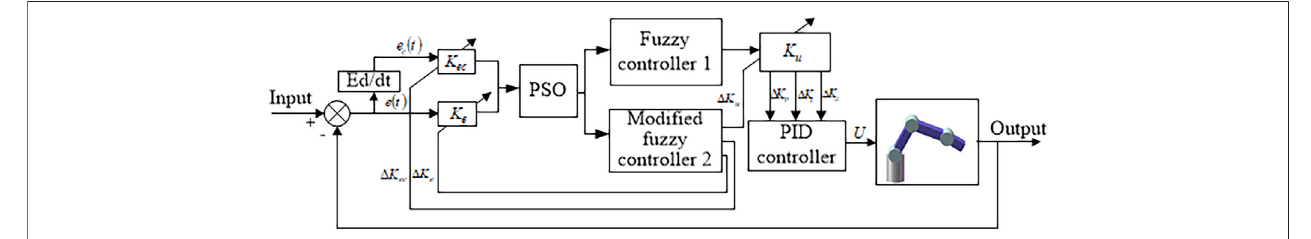
FIGURE 8 | Self-tuning fuzzy PID control system based on PSO.